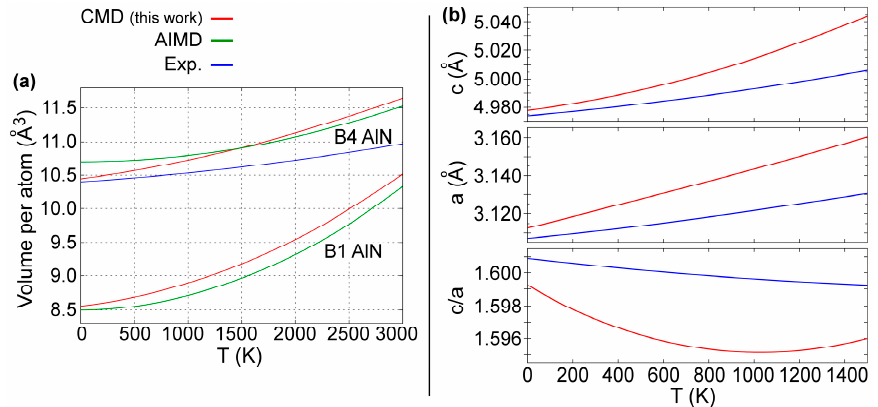
Figure 4. ( a ) Temperature dependence of B4-AlN and B1-AlN equilibrium volumes as predicted using CMD and AIMD simulations [50] and experiments [86]. The experimental curve (blue) was obtained from the a and c/a ratio variation versus T determined in Ref. [86]. ( b ) Temperature dependence of a, c, and c/a ratio of B4-AlN lattice parameters as predicted using CMD (red solid line) and measured using X-ray powder diffractometry (blue solid line) in the temperature range 300 to 1400 K from Ref. [86].